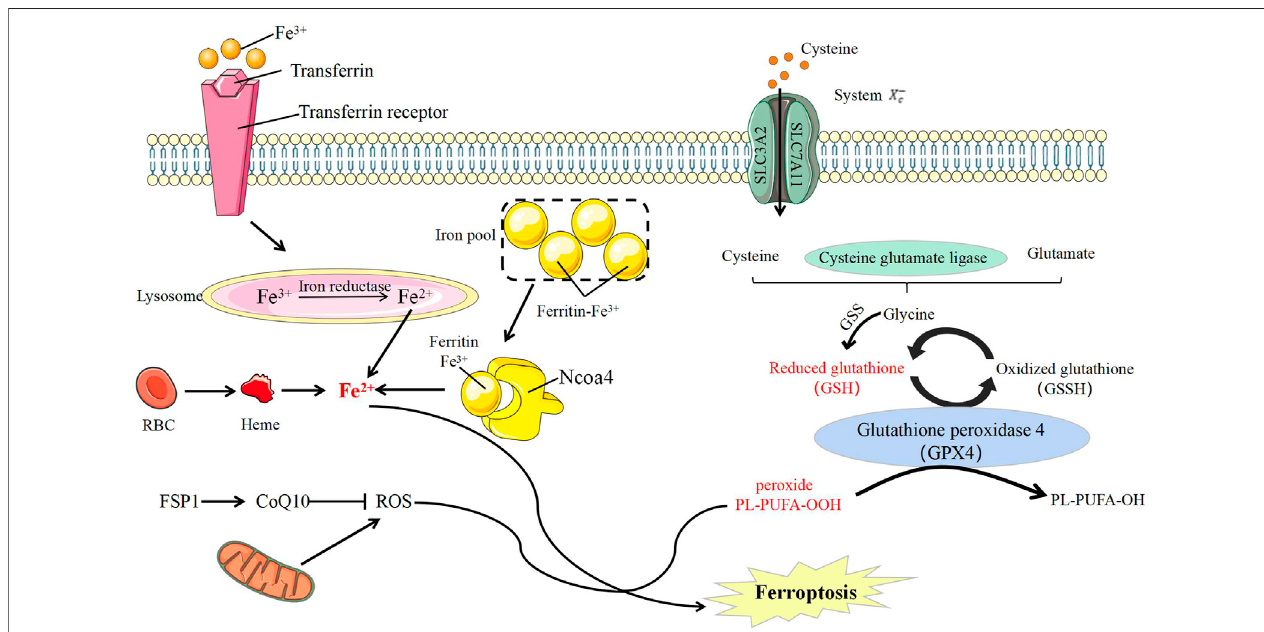
FIGURE 4 | Ferroptosis molecule and its regulation. CoQ10, Coenzyme Q10; FSP1, Ferroptosis-suppressor-protein 1; GSS, glutathione synthetase; NCOA4, nuclear receptor coactivator-4; RBC, red blood cells; ROS, reactive oxygen species; PL, Phospholipid; PUFA, polyunsatureated fatty acid; SLC3A2, solute carrier 3A2; SLC7A11, solute carrier 7A11; System Xc-, the cystine/glutamate antiporter system.